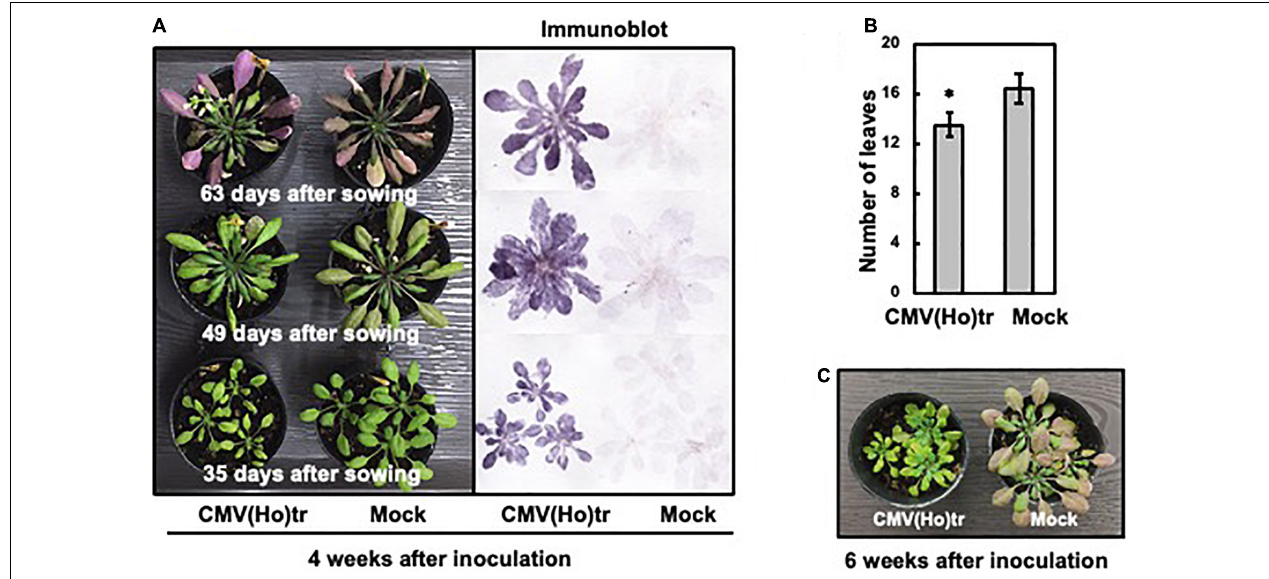
FIGURE 4 | The influence of infection with CMV(Ho)tr on the growth of A. thaliana ecotype Col-0, which was assessed at three different growth stages. Fully expanded leaves of Col-0 plants, which were cultivated for 7, 21, or 35 days, were inoculated with CMV(Ho)tr or sodium phosphate buffer (pH 7.0) as a control (mock) and further cultivated for 4 weeks after inoculation [left panel in (A) ]. Thus, the ages of each plant in (A) were different at 35, 49, and 63 days, respectively, but all at 4 weeks post-infection. After photographing the plants, virus coat protein was detected immunologically by a tissue-printing method [right panel in (A) ]. The average number of detached leaves from three independent 35-day-old plants is shown in the bar chart with error bars ( n = 10, SD). An asterisk denotes the statistically significant difference between CMV(Ho) and mock control plants (Welch’s t -test, p < 0.01) (B) . CMV(Ho)tr- and mock-inoculated plants, which were inoculated at 7 days after sowing and further cultivated for 6 weeks after inoculation [infected with CMV(Ho)tr at 7 days post-sowing], were photographed (C)